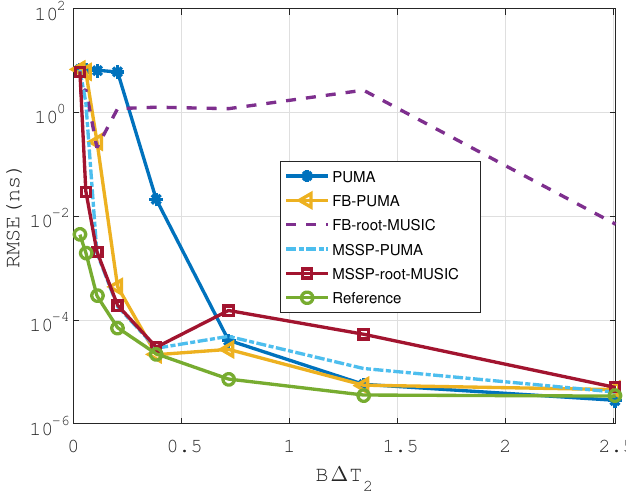
Figure 8. RMSE versus B ∆ T 2 , Scenario 3, SNR =